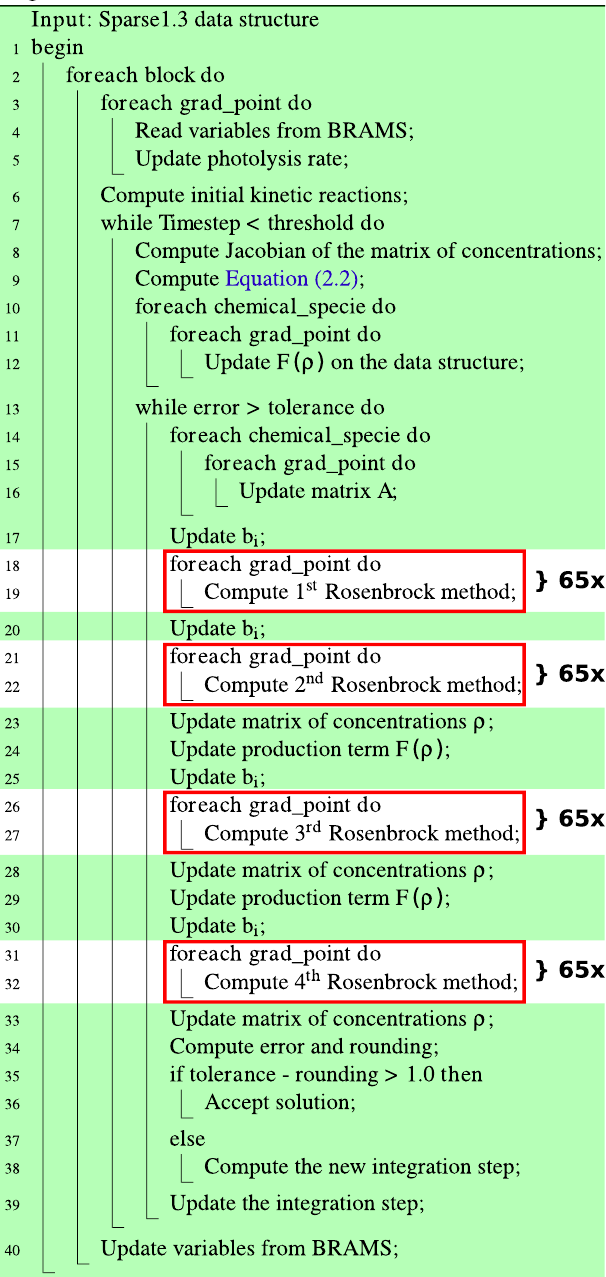
Figure 1. Pseudocode of the Rosenbrock method block for 65 columns. Equation (2.2) stands for the linear system